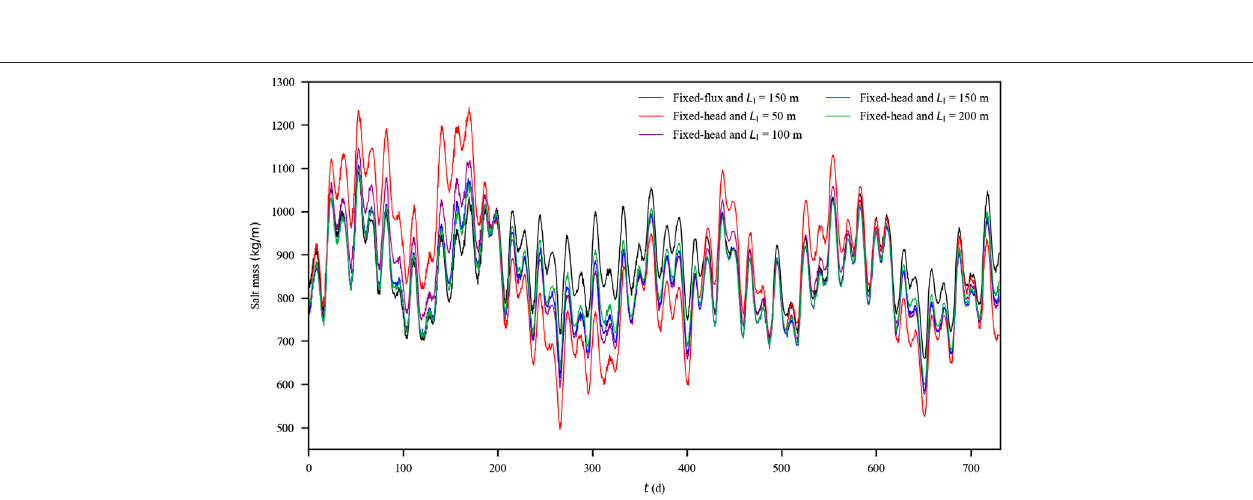
Frontiers in Environmental Science |